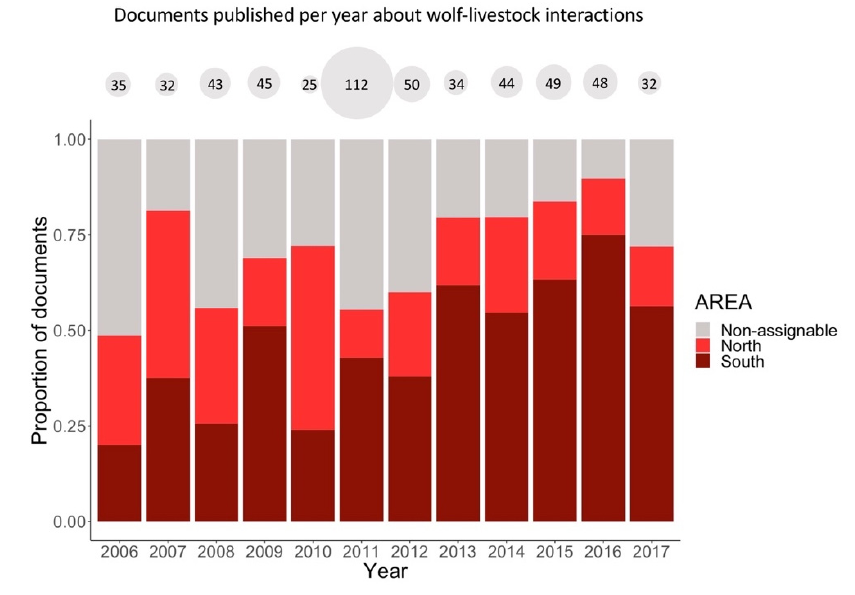
Figure 4. Proportion of documents published annually about wolf-livestock interactions according to the three categories of areas considered: north of the River Douro, south of the River Douro, and non-assignable (i.e., larger spatial scales or generic documents). The total number of documents published every year on wolf-livestock interactions is shown in grey circles above the figure.